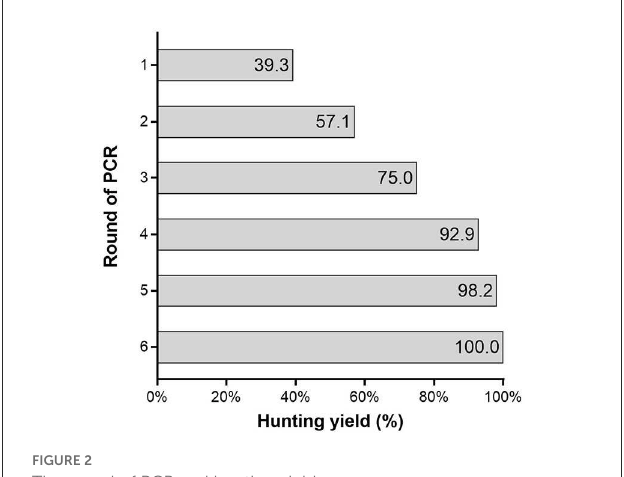
FIGURE2 The round of PCR and hunting yield.